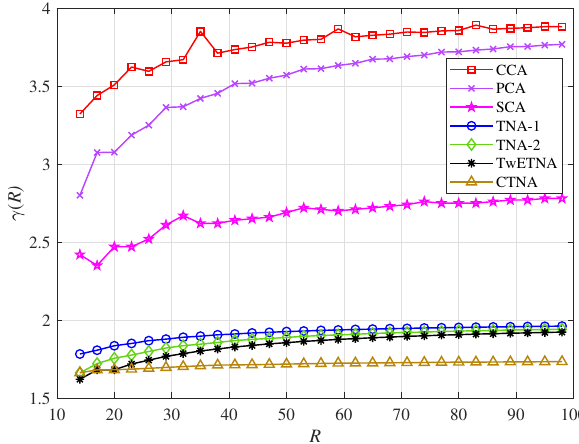
Figure 4. DOF ratio γ ( R ) versus the number of sensors R .